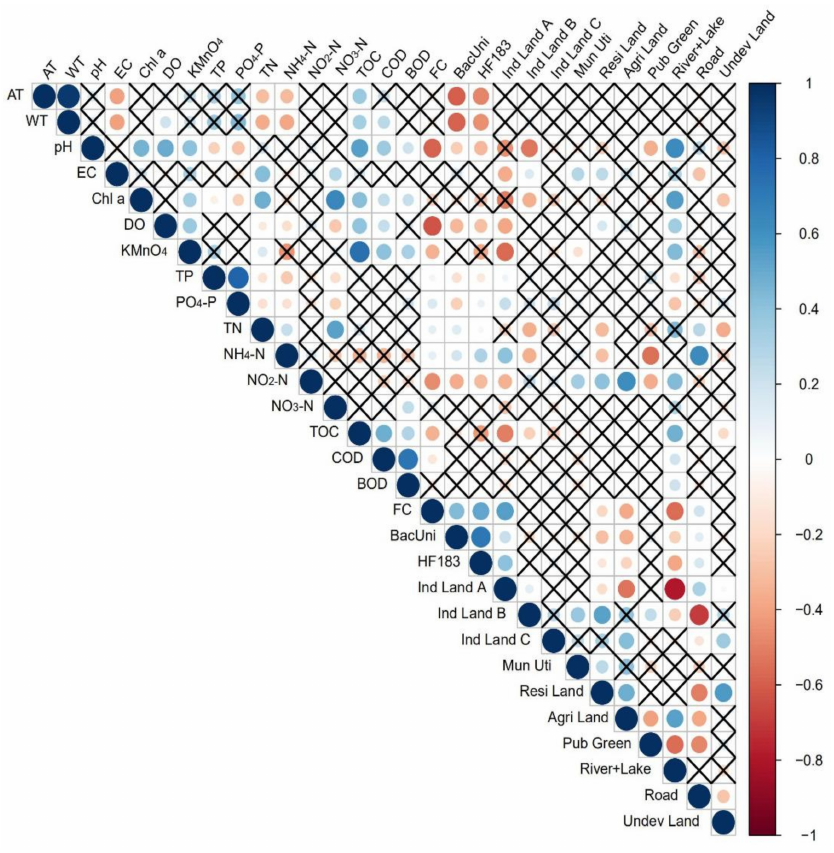
Figure 8. Spearman’s correlation map of the physicochemical, microbiological, and land use pattern percentages. Each correlation was presented by one colored circle in the figure. The blue color indicated positive correlations, while the red color indicated negative correlations. Depth of the colors and sizes of the circles indicated strengths of the correlations. Non-significant ( p > 0.05) correlations were presented by a cross on the circle. The control samples were not included. TC was excluded due to unavailability of the September data. (Ind Land A, B, C—Class A, B, C Industrial Land, respectively; Mun Uti—Municipal Utilities; Resi Land—Residential Land; Agri Land—Agricultural Land; Pub Green—Public Green Land; Undev Land—Undeveloped